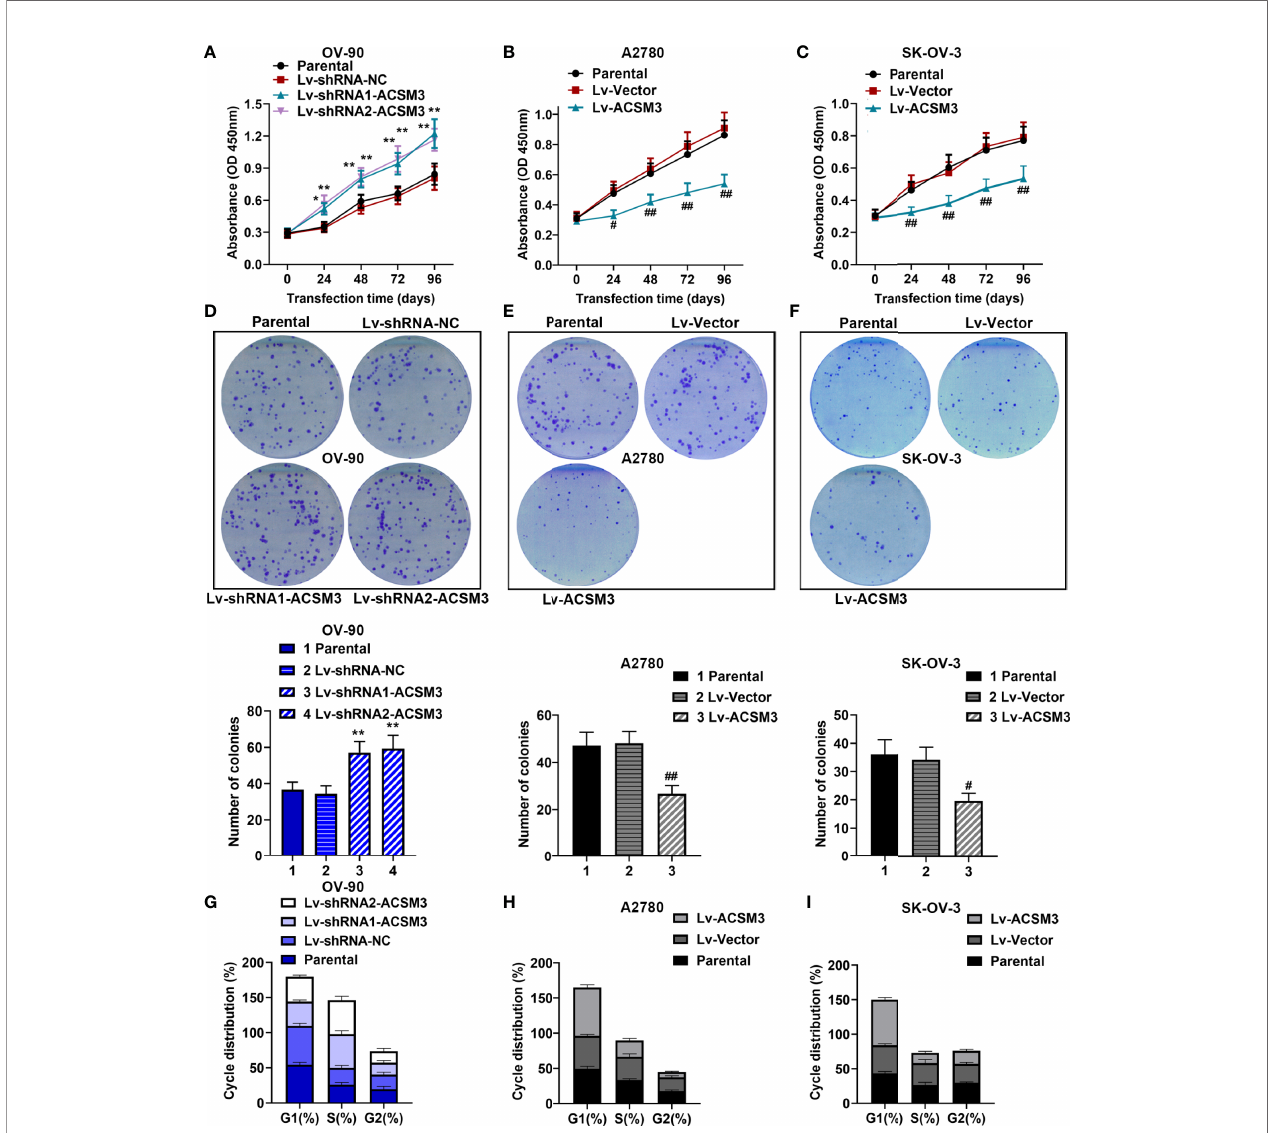
FIGURE 2 | Effects of ACSM3 on the proliferation of ovarian cancer cells. OV-90 cells were infected with ACSM3 shRNAs. A2780 or SK-OV-3 cells were infected with overexpressed ACSM3 vectors. (A – C) OV-90, A2780, or SK-OV-3 cells were subjected to CCK-8 assay. (D – F) The number of colonies. (G – I) Cell cycle arrest was detected by the fl ow cytometer. Measurement data were expressed as mean ± SD of three independent experiments. *p < 0.05, **p < 0.01 versus Lv-shRNA- NC; # P < 0.05, ## P < 0.01 versus